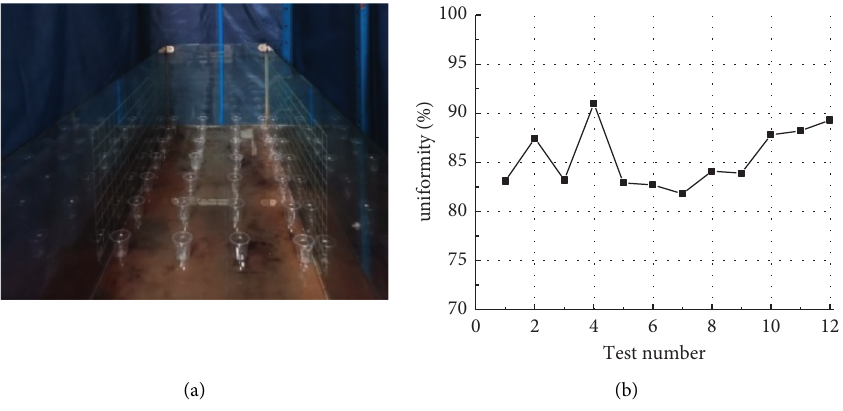
Figure 3: Rainfall dispersion test. (a) Rainfall dispersion experiment. (b) The uniformity of each test.